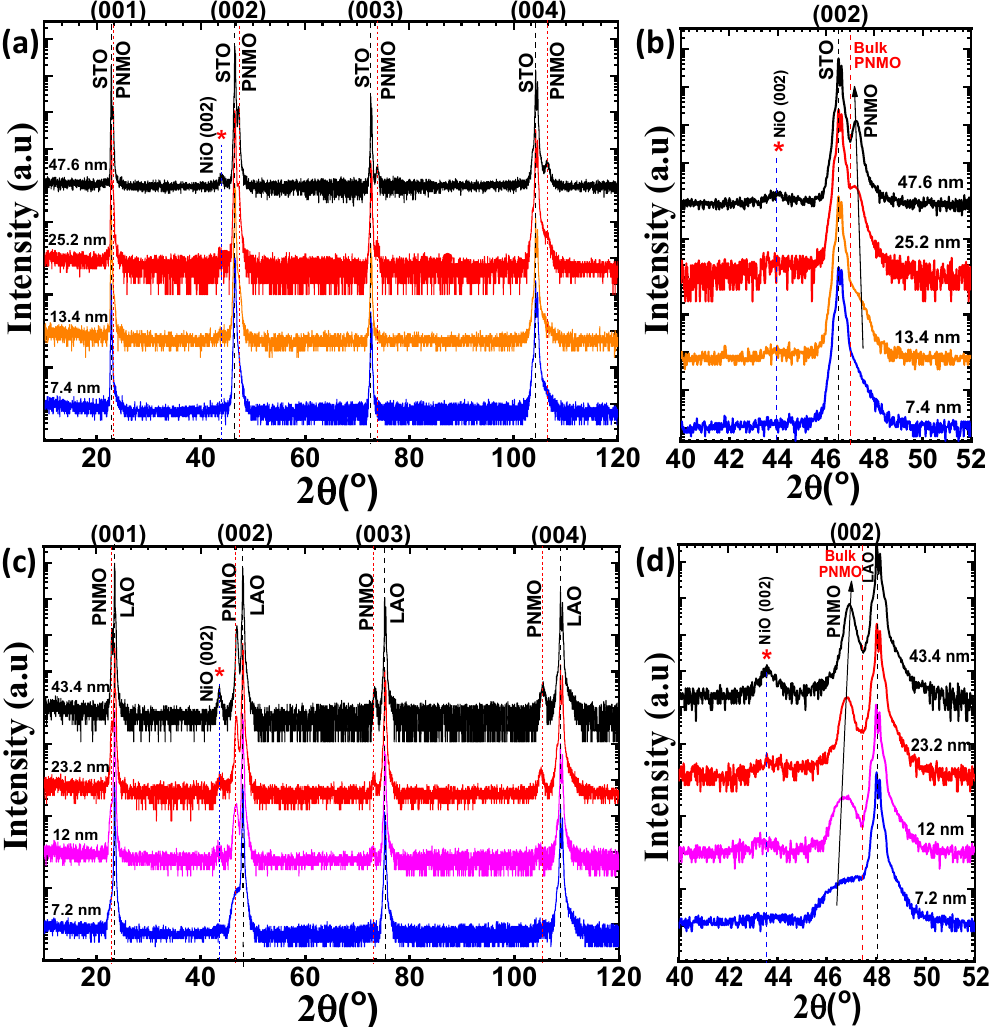
Figure 1. XRD θ /2 θ scans of PNMO thin films grown/annealed at 800 °C under 350 mTorr O 2 on ( a ) (001) STO and ( c ) (001) LAO substrates. ( b ) Zoom of the (002) reflection of both STO and PNMO. ( d ) Zoom of the (002) reflection of both LAO and PNMO. Parasitic phases are denoted by ( * ). For more details, Figure 1b,d show the (002) reflection of both the STO and LAO substrates and the PNMO film, respectively. As expected, the (002) peak of the film is placed at a 2 θ position larger (smaller) than that of the bulk PNMO (see dashed vertical red line) for the PNMO/STO (PNMO/LAO) substrate. This observation indicates that the out-of-plane c lattice parameter shrinks when the film is under in-plane tensile strain and expands when it is under in-plane compressive strain, in agreement with the lattice mismatch imposing a tensile and a compressive in-plane strain. At the same time, in Figure 1b,d, it can be appreciated that the position of the (002) peak shows a slight shift towards lower 2 θ angles (higher 2 θ angles) when increasing the film thickness for PNMO/STO (PNMO/LAO) substrate (see arrow). This indicates that the out-of-plane c lattice parameter of the